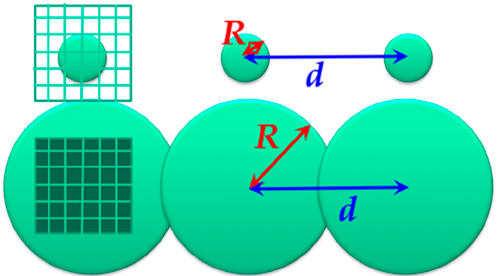
Figure 7. The 100 spheres aligned with the distance, d = 1.5. Sphere radii were taken as 0.05 < R <